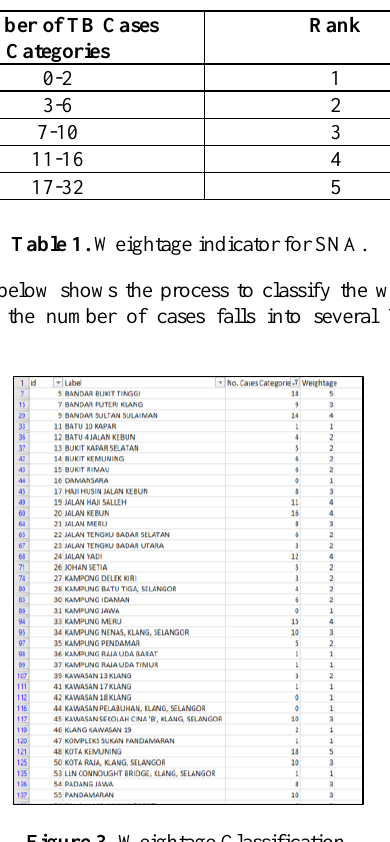
Figure 3. Weightage Classification.